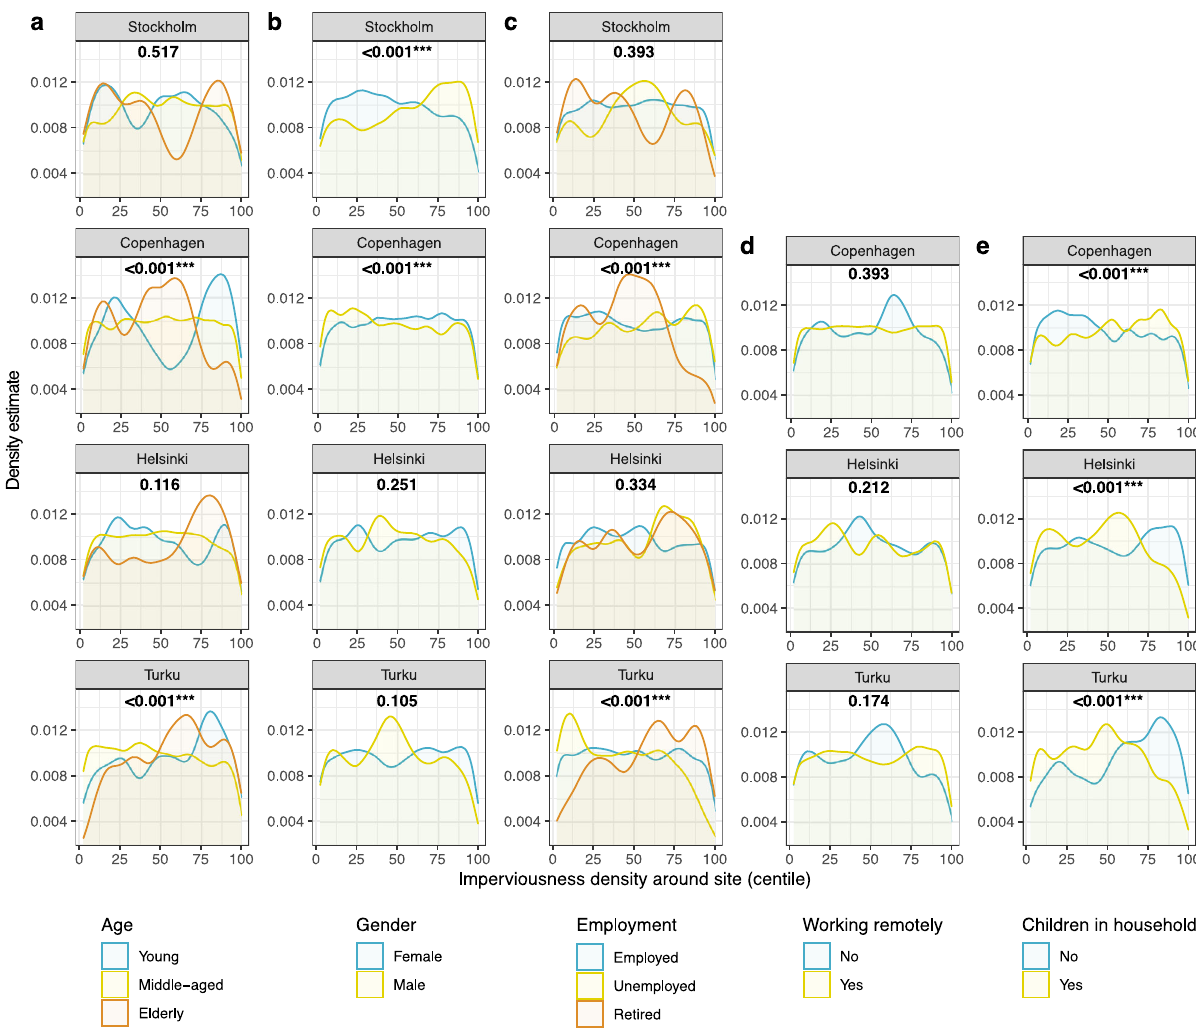
Fig. 4 Imperviousness density (ID) within 300m distance around the visited outdoor recreation sites. ID in centiles of rank order is given on the x -axis and kernel density estimates are given on the y -axis. Panels show data broken down by city and a age, b gender, c employment, d remote working, and e children in household. The numbers in each plot correspond to the p -value for the Mann – Whitney U -test or Kruskal – Wallis test for differences between groups shown in the plot. Rank order centiles are shown to illustrate group differences as estimated by the tests used. See also Supplementary Tables 3, 5, 7 and 9 on statistical results as